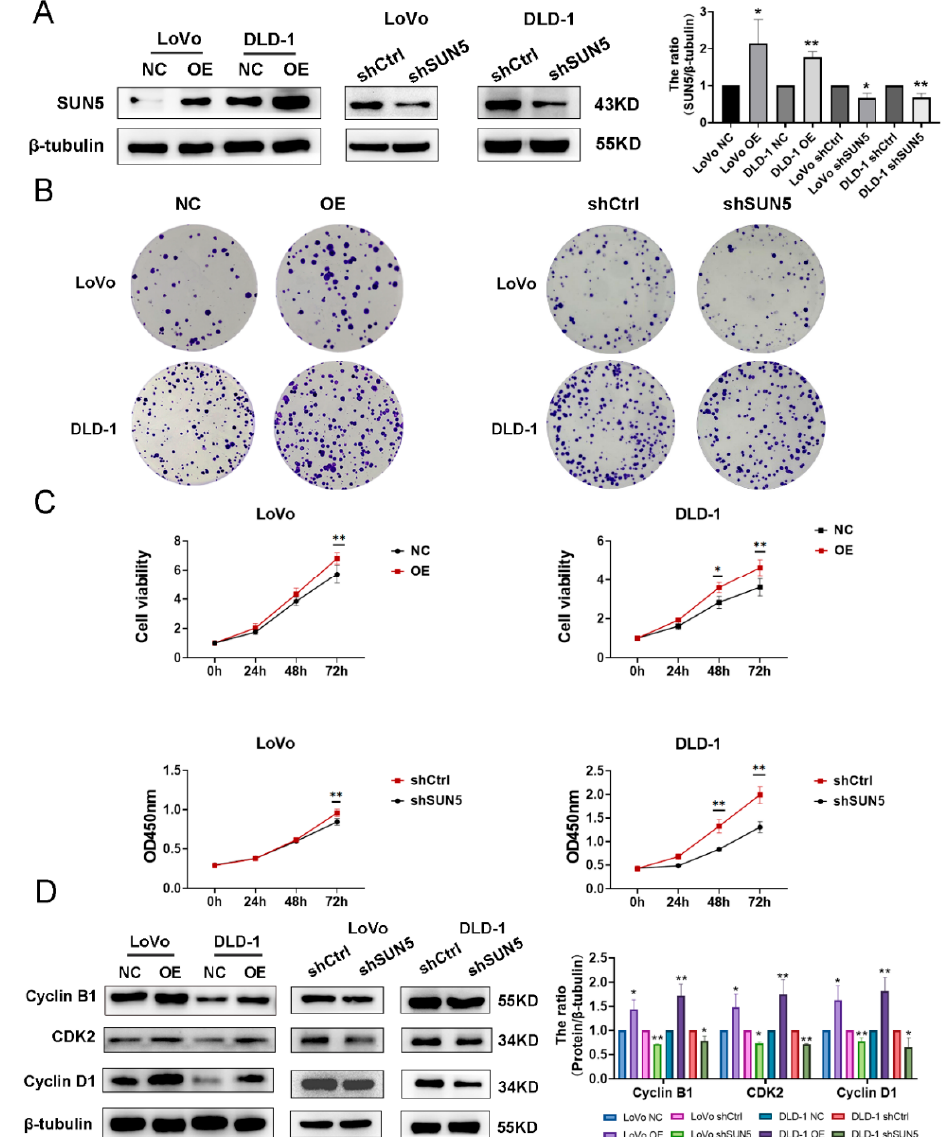
Figure 2. Overexpression of SUN5-promoted proliferation, while knockdown of SUN5 inhibited the proliferation of colorectal cancer cells in vitro. ( A ) Transfection of SUN5 overexpression (OE) lentivirus upregulated SUN5 expression when compared with the control lentivirus (NC), while shRNA silence of SUN5 (shSUN5, also called SUN5-KD) downregulated SUN5 expression when compared with the negative control shRNA (shCtrl) in LoVo and DLD-1 cells by Western blotting. β -tubulin was used as an internal control. ( B , C ) Overexpression or knockdown of SUN5 promoted or inhibited cell proliferation of CRC cells measured by colony-formation and CCK-8 assays (* p < 0.05; ** p < 0.01). ( D ) Cyclin D1, CDK2, and Cyclin B1 were determined by Western blotting after overex- pression or knockdown of SUN5 in LoVo and DLD-1 cells (* p < 0.05, ** p <